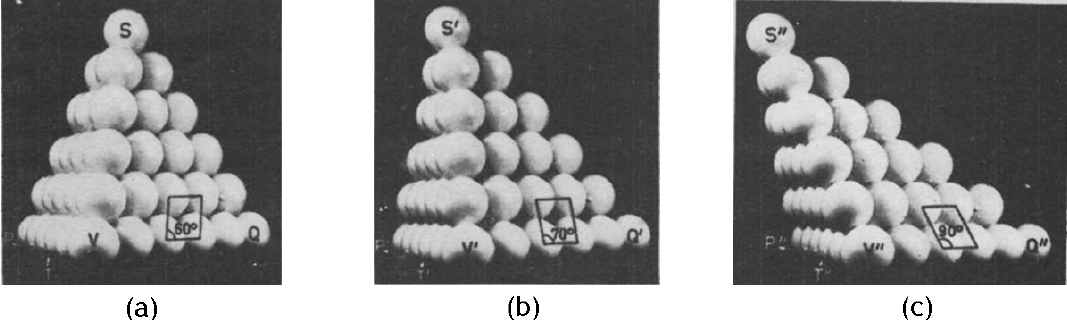
Figure 6. Hard-sphere model proposed by Bogers and Burgers for the fcc-bcc transformation and fcc-fcc deformation twinning. The initial fcc structure ( a ) becomes, after distortion, a new twinned fcc structure ( c ). The bcc structure is at the midway between the two structures ( b ); however, additional shears are required to place the atoms at their correct positions. Reprinted from [53] with permission from Elsevier.